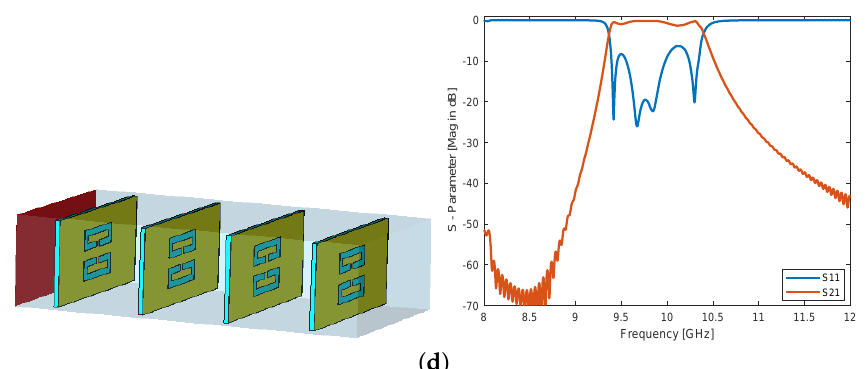
Figure 13. Design steps of bandpass waveguide filter based on rectangular meta-resonator and its S-parameters for ( a ) first resonator and its S-parameter; ( b ) second resonator is added to the first one and its S-parameter; ( c ) the third resonator is added to both resonators and its S-parameter; ( d ) the fourth resonator is added in, cascaded to three resonators and its S-parameter.